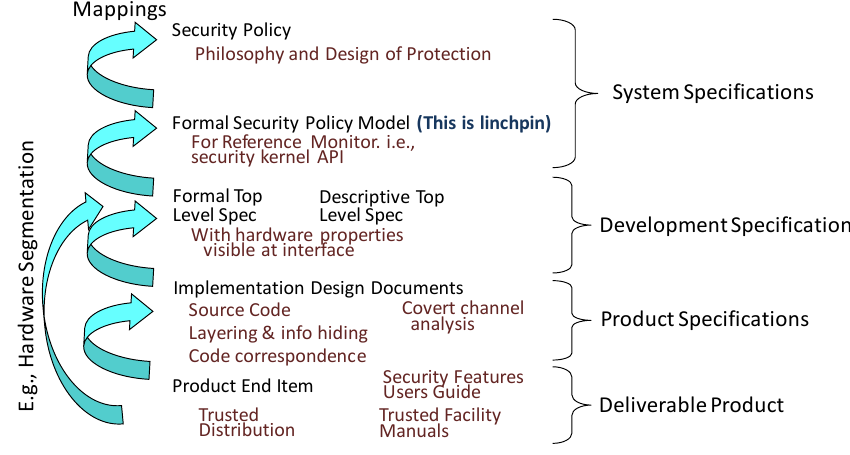
Figure 2. Systematic security kernel engineering process.